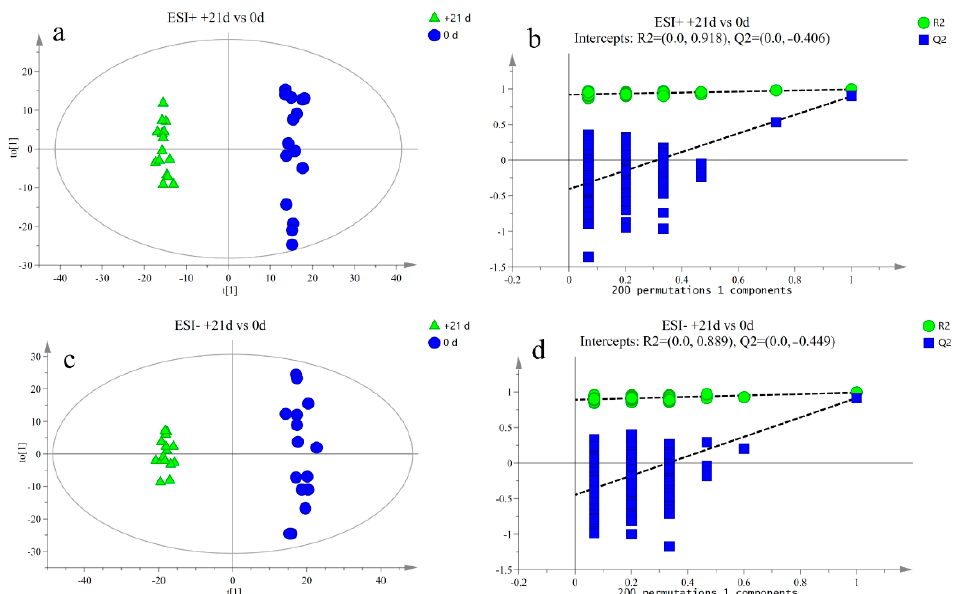
Figure 5. ( a , b ) Orthogonal partial least squares discriminant analysis (OPLS-DA) of scores and permutation test plots for the +21 d and 0 d group samples analyzed in the positive ion mode, respectively. ( c , d ) Orthogonal partial least squares discriminant analysis of scores and permutation test plots for the +21 d and 0 d group samples analyzed in the negative ion mode, respectively. t[1]—first principal component; to [1]—second orthogonal component. The intercept limit of Q 2 , calculated by regression line, is the plot of Q 2 from permutation test in the OPLS-DA model.